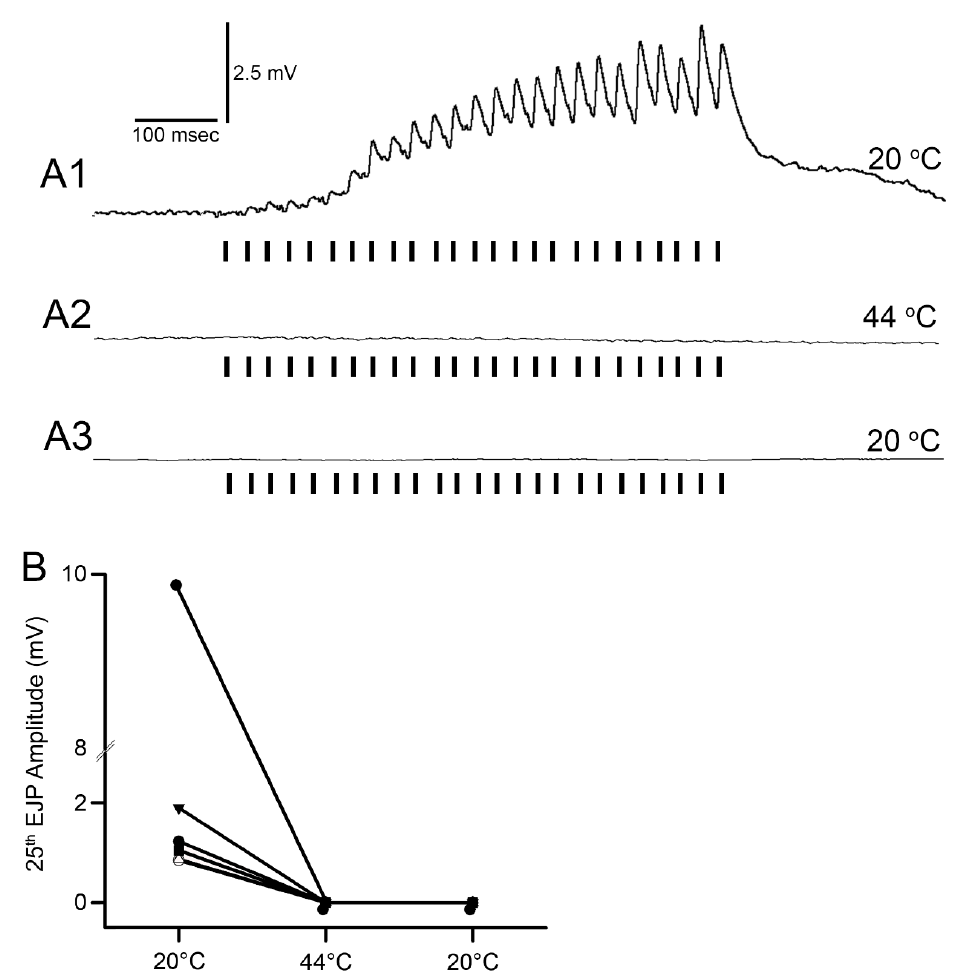
Figure 11. The excitatory junction potentials (EJPs) recorded from the opener muscle at various temperatures. ( A1 ) Representative trace of the EJPs recorded with an intracellular electrode from the distal muscle fibers in opener muscle of a crayfish walking leg at 20 °C. The responses show a marked facilitation that occurs throughout the stimulation train delivered at 40 Hz for 25 stimuli. ( A2 ) The EJPs are not able to be observed at 44 °C. ( A3 ) Upon returning the preparation to 20 °C, the EJPs are still absent. The vertical bars represent the 25 stimuli pulses. ( B ) The mean 25th EJP amplitude (mV) for each opener muscle preparation at each temperature is shown (N = 6, significant difference between 20 °C and 44 °C, p < 0.05 paired t -test).